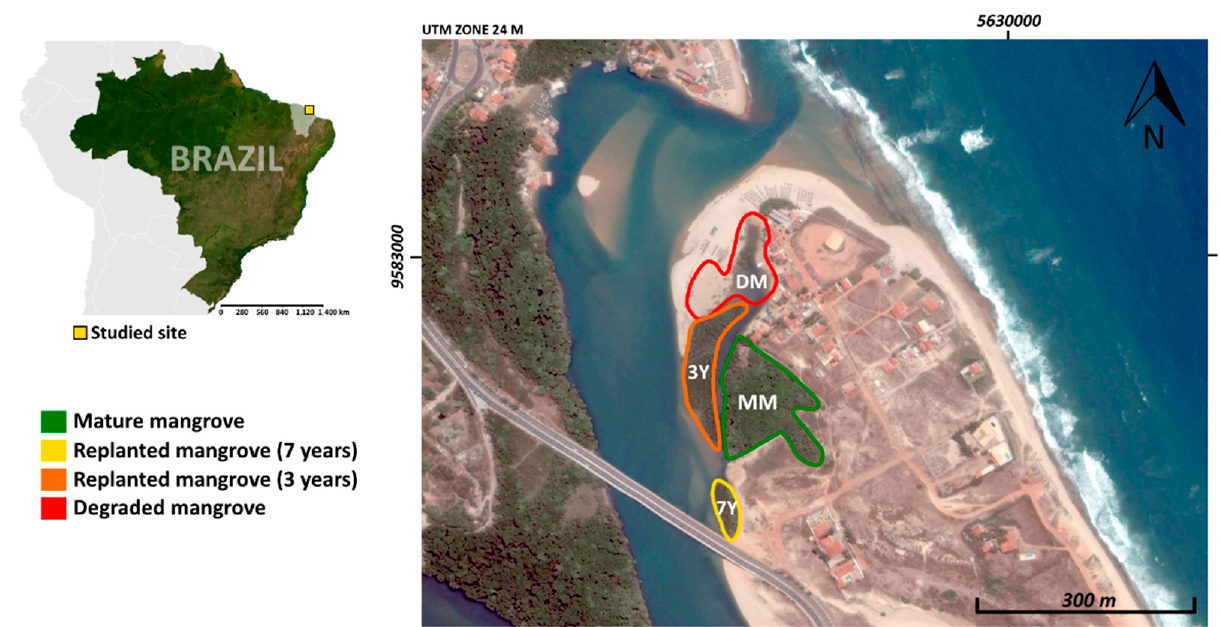
Figure 1. Sampled mangroves at the estuary of Cocó river, northeast Brazil. The location of the planted, mature, and degraded mangroves are highlighted. Satellite image was obtained from Google Earth Pro TM , the XY axes represent UTM coordinates. DM: degraded mangrove, 3Y: mangroves with 3 years of planting, 7Y: mangroves with 7 years of planting, MM: mature mangrove forest.